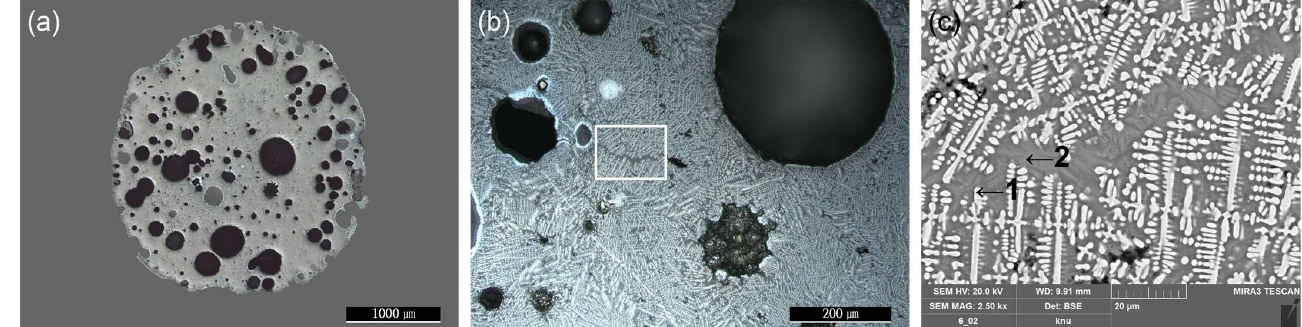
Figure 4. Microstructure and SEM image of spheroidal hammer scale (No. 1) ( a ) whole image, ( b ) metallographic microscope detailed image and rectangle is position of the SEM analysis, ( c ) position of SEM image and EDS analysis; 1: wüstite, 2: kirschsteinite. Table 2. EDS analysis results of spheroidal hammer scale (No. 1).